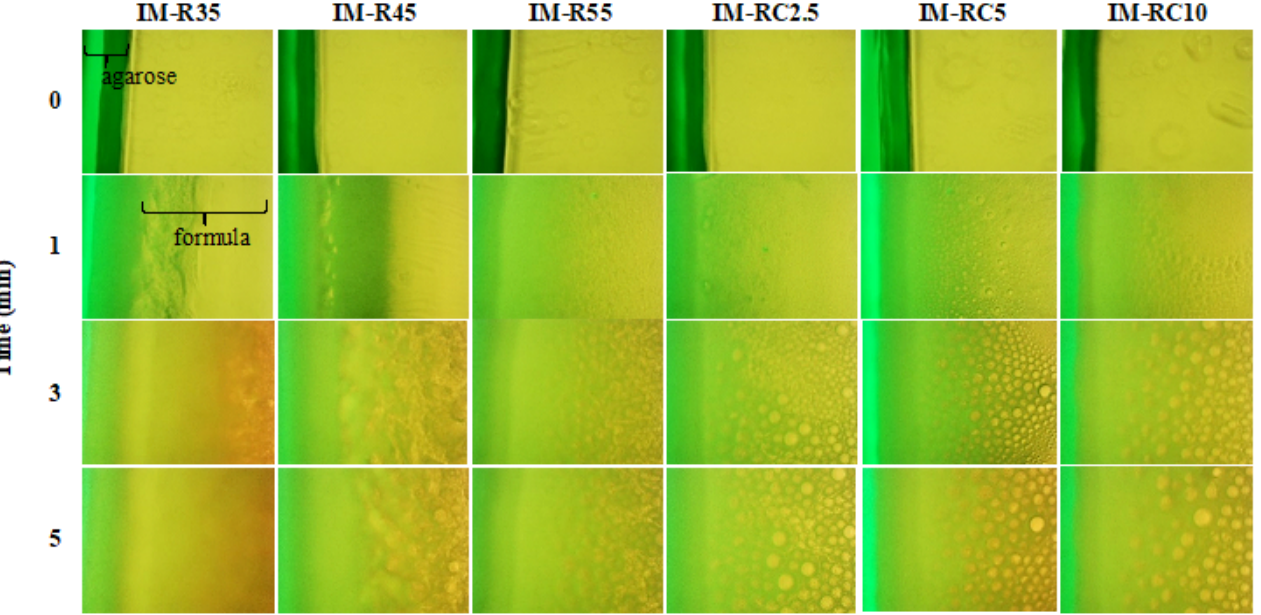
Figure 4. Interfacial phenomena changes of rosin in situ gel with different concentrations of CO after contact with an aqueous agarose gel phase under stereomicroscope with various time interval (40×).